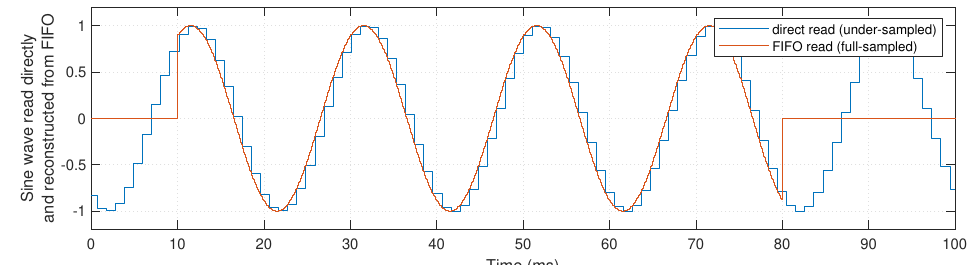
Figure 17. Comparison between the waveforms read directly from the AXI interface (under-sampled) and retrieved from the FIFO (full-sampled), with a processor sampling time of 1050 µ